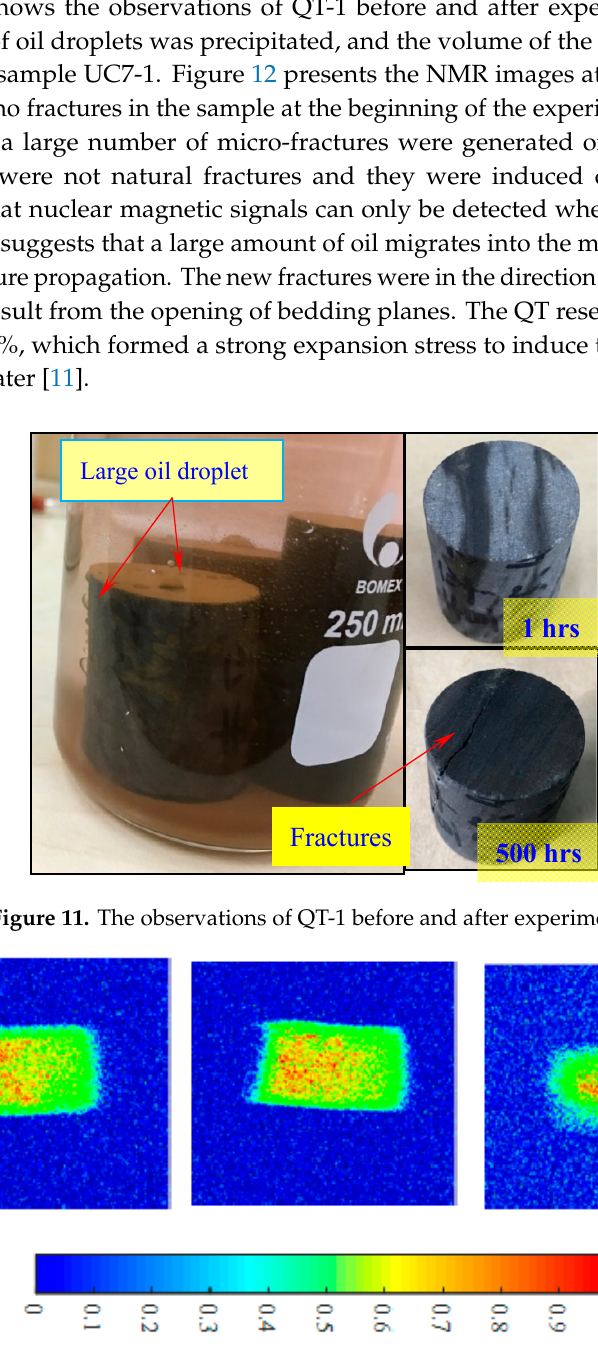
Figure 10. Oil recovery in different diameter pores: ( a ) UC7-2 and ( b ) LC7-2.